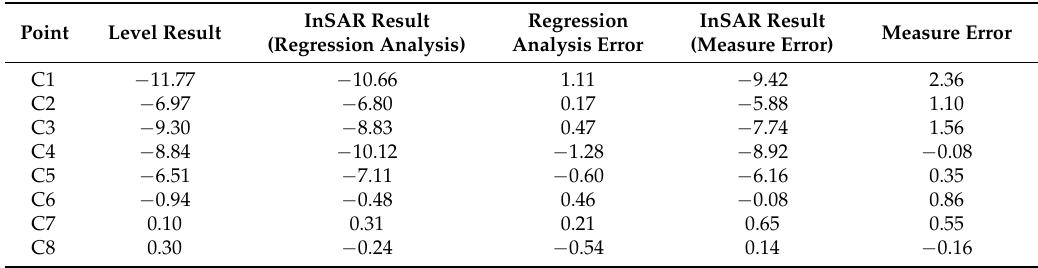
Table 7. Detailed analysis between regression analysis and measure error